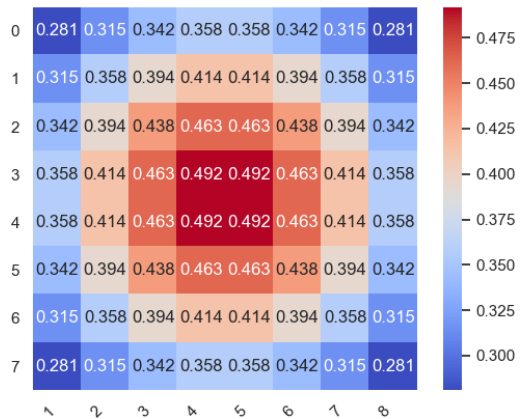
Figure 1. The closeness centrality of an 8 × 8 2D Mesh network. It is used to partition the priority of the nodes to make routing